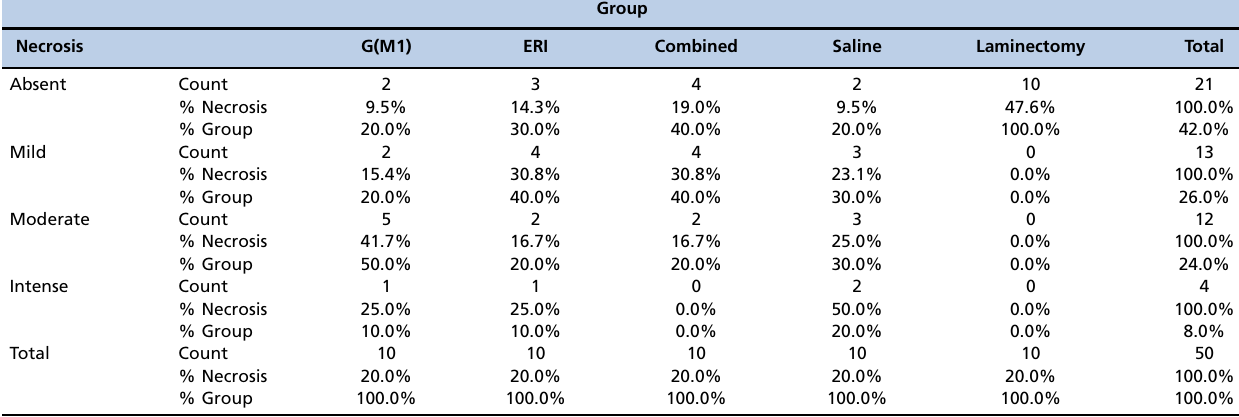
Table 3 - Necrosis in the distal section of the spinal cord in Wistar rats subjected to experimental spinal cord contusion lesioning.